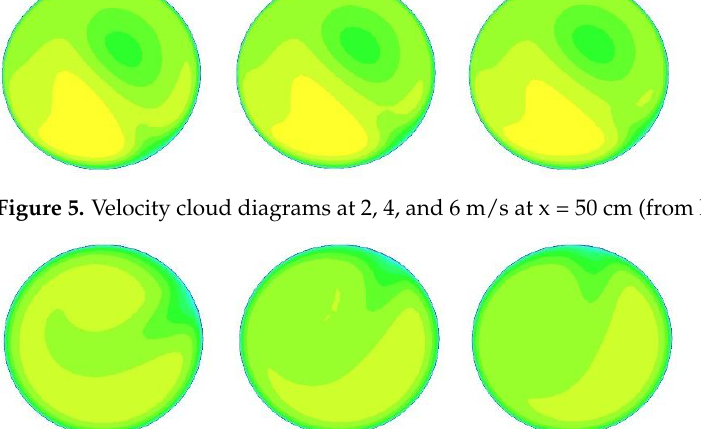
Figure 4. Velocity cloud diagrams at 2, 4, and 6 m/s at x = 15 cm (from left to right).